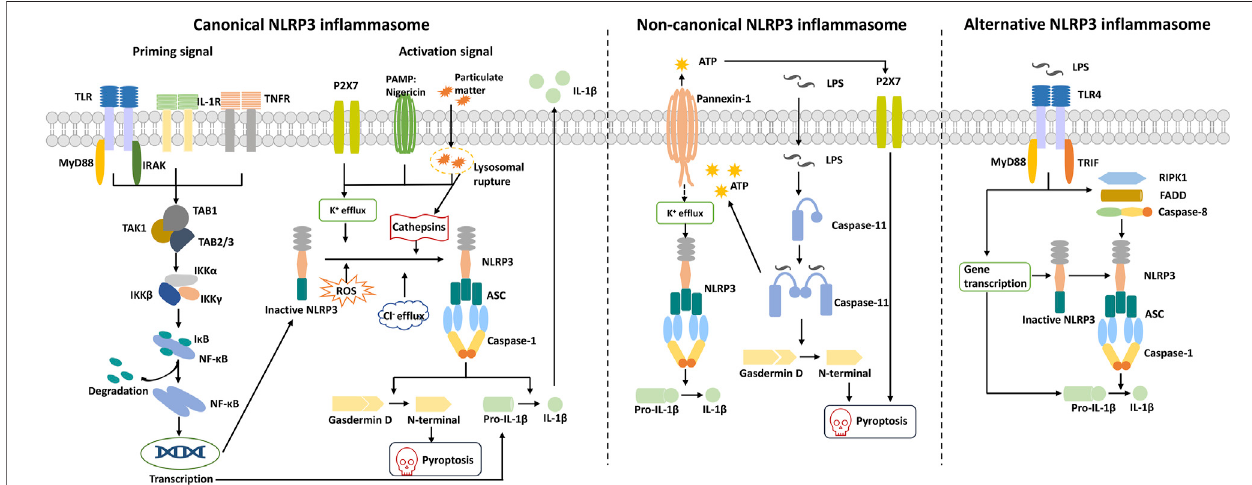
FIGURE 2 | Mechanisms of NLRP3 in fl ammasome activation. Canonical NLRP3 in fl ammasome activation requires two signals: a priming signal and an activation signal.TheprimingsignalistriggeredbyendogenouscytokinesormicrobialmoleculesandcausestheupregulationofNLRP3andpro-IL-1 β throughtheactivationofthe transcriptionfactorNF- κ Bsignalingpathway.Theactivationsignalistriggeredbyvariousstimuli,suchaspore-formingtoxins,particularmatter,andviralRNA,whichcan induceK + ef fl ux,Cl − ef fl ux,mitochondrialdysfunction(ROSrelease),andlysosomaldisruption(cathepsins).TheseeventspromoteNLRP3oligomerizationtorecruit ASC and pro-caspase-1 and form the activated NLRP3 in fl ammasome. Activated caspase-1 cleaves gasdermin D to release the N-terminal domain and induce pyroptosis. Meanwhile, caspase-1 cleaves pro-IL-1 β to IL-1 β and is released to the extracellular matrix. Non-canonical NLRP3 in fl ammasome activation is induced by cytosolic LPS released from gram-negative bacteria. LPS is delivered into the cytosol and activates caspase-11, whose activated state can trigger the pannexin-1 channel to induce K + ef fl ux and ATP release. Subsequently, the NLRP3 in fl ammasome is activated, and mature IL-1 β is released. Activated caspase-11 also induces pyroptosis via cleavage of gasdermin D and formation of pores on the cell membrane. Alternative NLRP3 in fl ammasome activation occurs when human monocytes are exposed to LPS, which requires RIPK1, FADD, and caspase 8 to activate the NLRP3 in fl ammasome rather than K + ef fl ux. ASC speck formation and pyroptosis are also absent in this